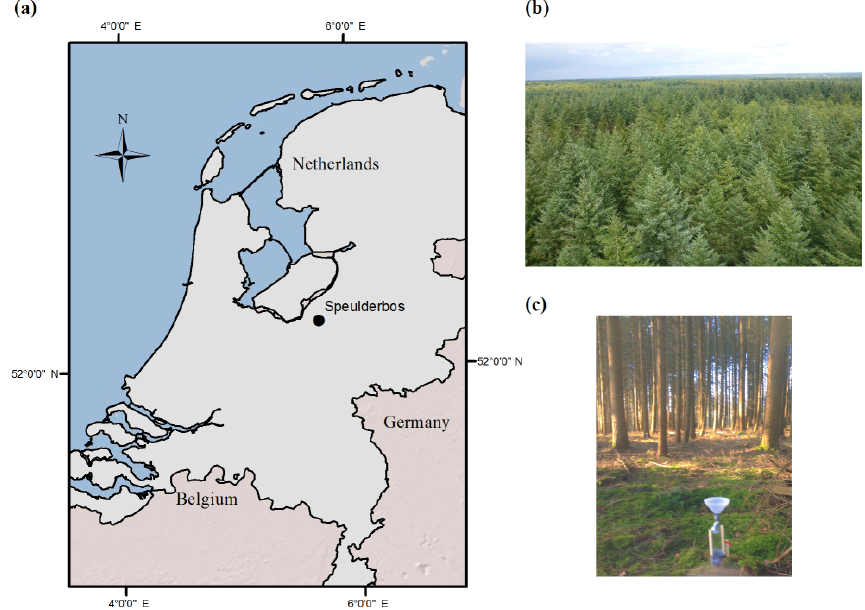
Figure 1. Study area in Speulderbos: (a) location map in the Netherlands; (b) top view of the canopy; (c) funnel-type collector used to quantify throughfall in the study